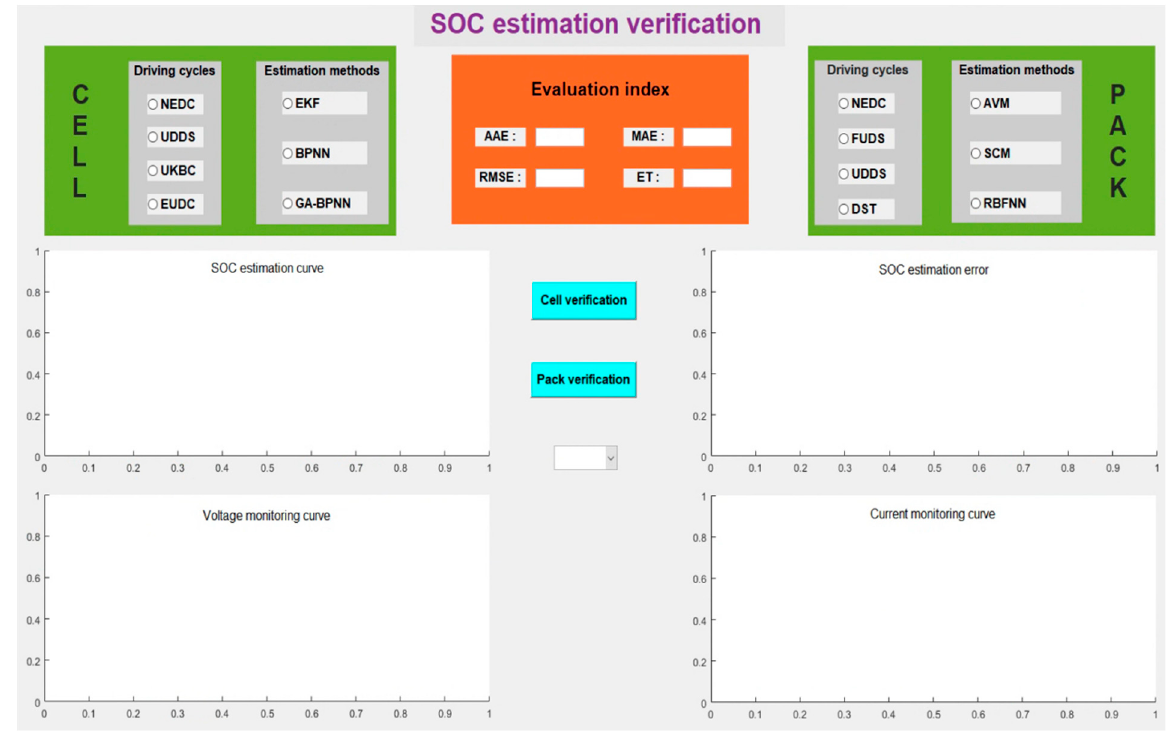
Figure 12. Initial interface of the upper computer software.